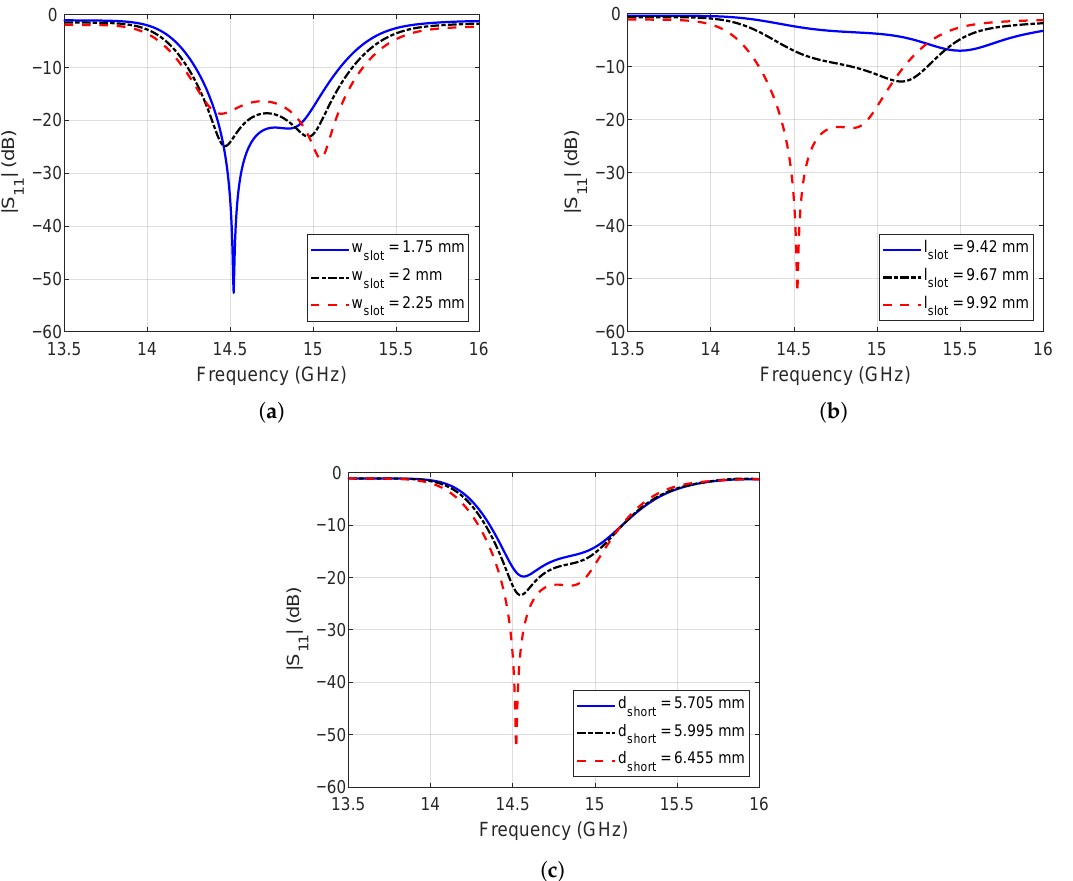
Figure 6. | S 11 | versus ( a ) w slot , ( b ) l slot and ( c ) d short . For each parameter variation, the remaining ones have been fixed to the nominal design values reported in Table 1.